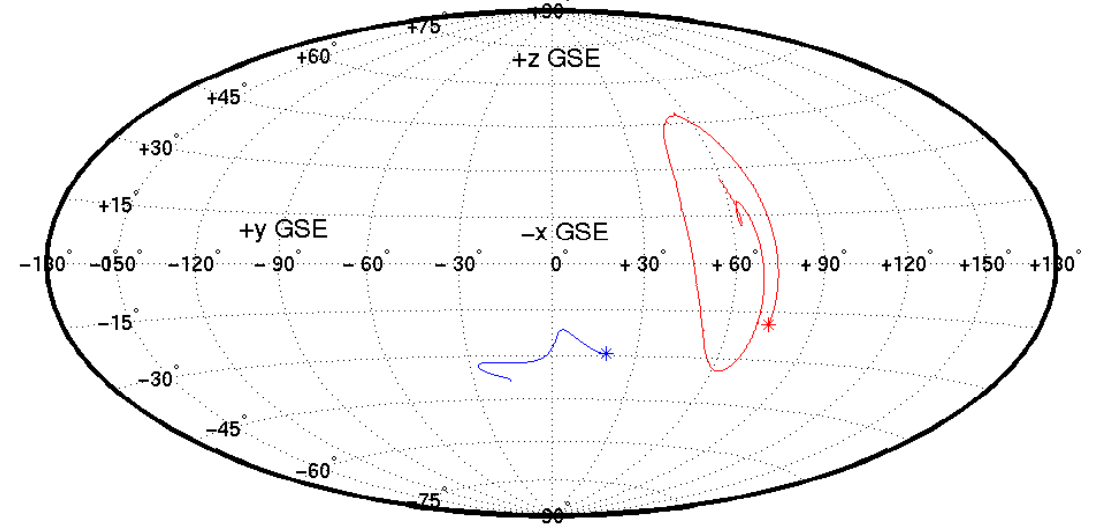
Fig. 3. Polar map of the instantaneous local wave vector direction of the wave packet shown in Fig. 2. The blue (red) curve shows the real (imaginary) local wave vector direction in GSE coordinates (looking towards the Earth at the origin and with the Sun at ± 180 ◦ on the horizontal parallel). The star on one end of the curve mark the beginning of the main wave event at 1 January 2001, 01:59:30 UT and the curves continue until the end of the main event which is 300s after the start. The wave is estimated to be propagating mainly along the anti-sunward direction ( − X GSE) at a velocity of 240km/s, consistent with a low frequency wave convected along the solar wind. The direction of the imaginary part of the wave vector is mainly orthogonal to the real part.